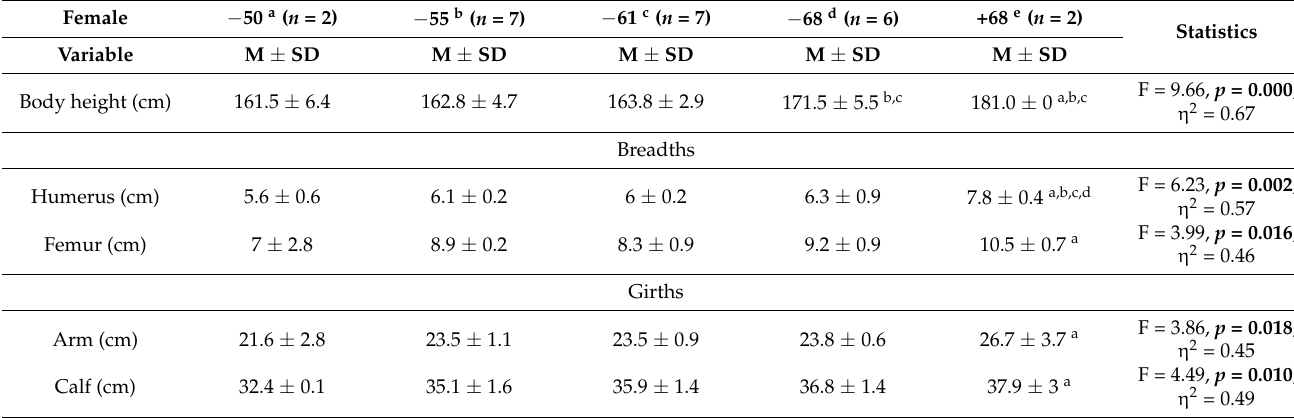
Figure 1. Somatochart of male karate athletes by weight categories. In the female groups, body height increased in relation to the weight category and differed significantly between <50 kg, <55 kg, <61 kg, and the heaviest group (>68 kg), and between the first two (<50 kg, and <55 kg) and <68 kg. The breadth of the humerus shows a difference between >68 kg and all of the other groups (<50 kg, <55 kg, <61 kg, <68 kg). The only difference in the breadth of the femur is between the lightest <50 kg) and the heaviest (>68 kg) category. Measuring arm circumference, there is one difference, between the <50 kg and >68 kg categories. Additionally, there is one difference between the groups in the circumference of the calf, between <50 kg and >68 kg. The categories did not differ significantly in terms of the thickness of the skin folds (Table 3). Table 2. Differences between weight categories of female